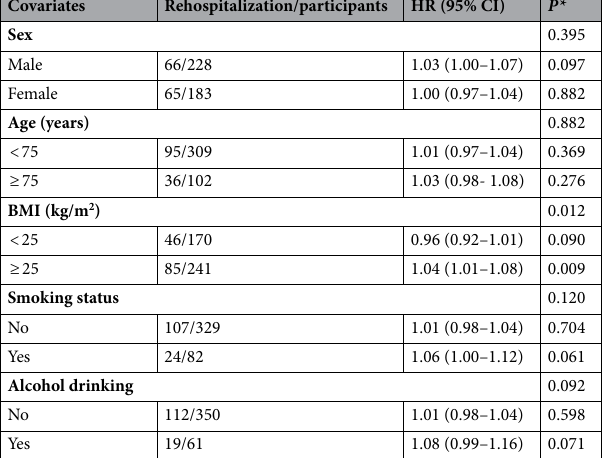
Covariates Rehospitalization/participants HR (95% CI)